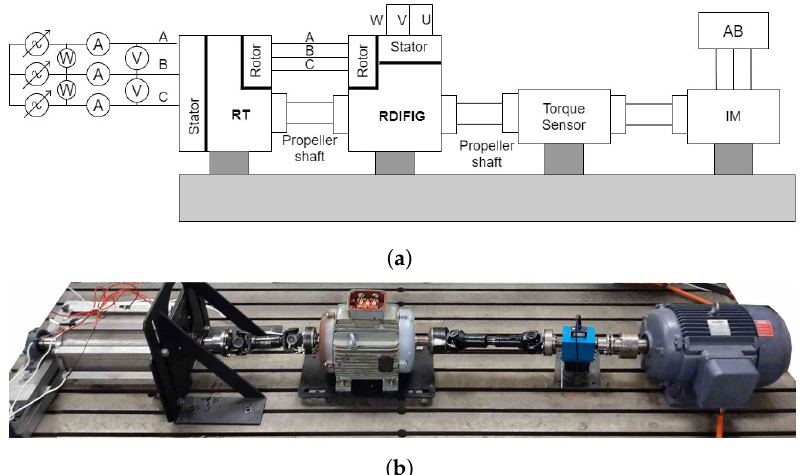
Figure 14. RDFIG with a rotary transformer: ( a ) test setup connection diagram and ( b ) lab test